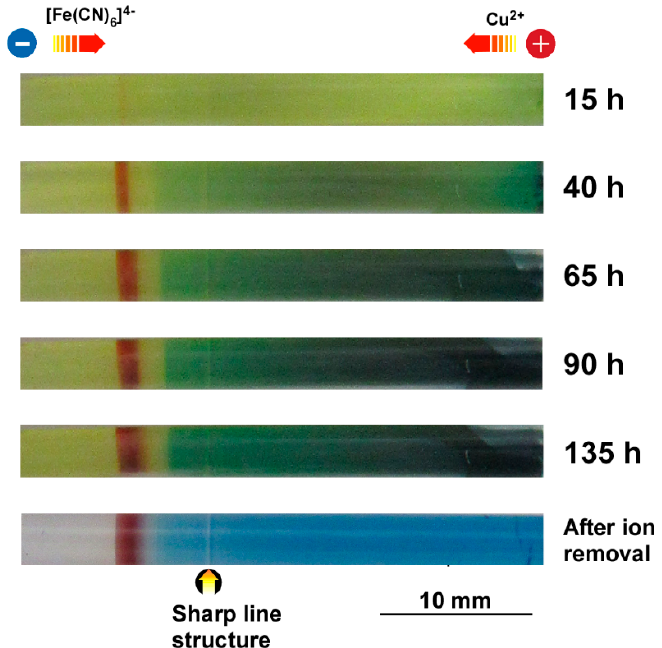
Figure 7. Spatiotemporal evolution of a multicolored pattern formed at 25 °C in the sample tube under an applied constant voltage of 4 V. The initial conditions are as follows: [[Fe(CN) 6 ] 3 − ] = 0.050 M and 2.0 mass% agarose. The elapsed time after voltage application is indicated at the right of each image. Bottom: the pattern after removing unreacted ions. The arrow at the bottom indicates the positions of the sharp line structure. A scale bar is also provided at the bottom of the image. Top: illustration of the charges of the electrodes and the movement direction of reactant ions induced by the electric field.